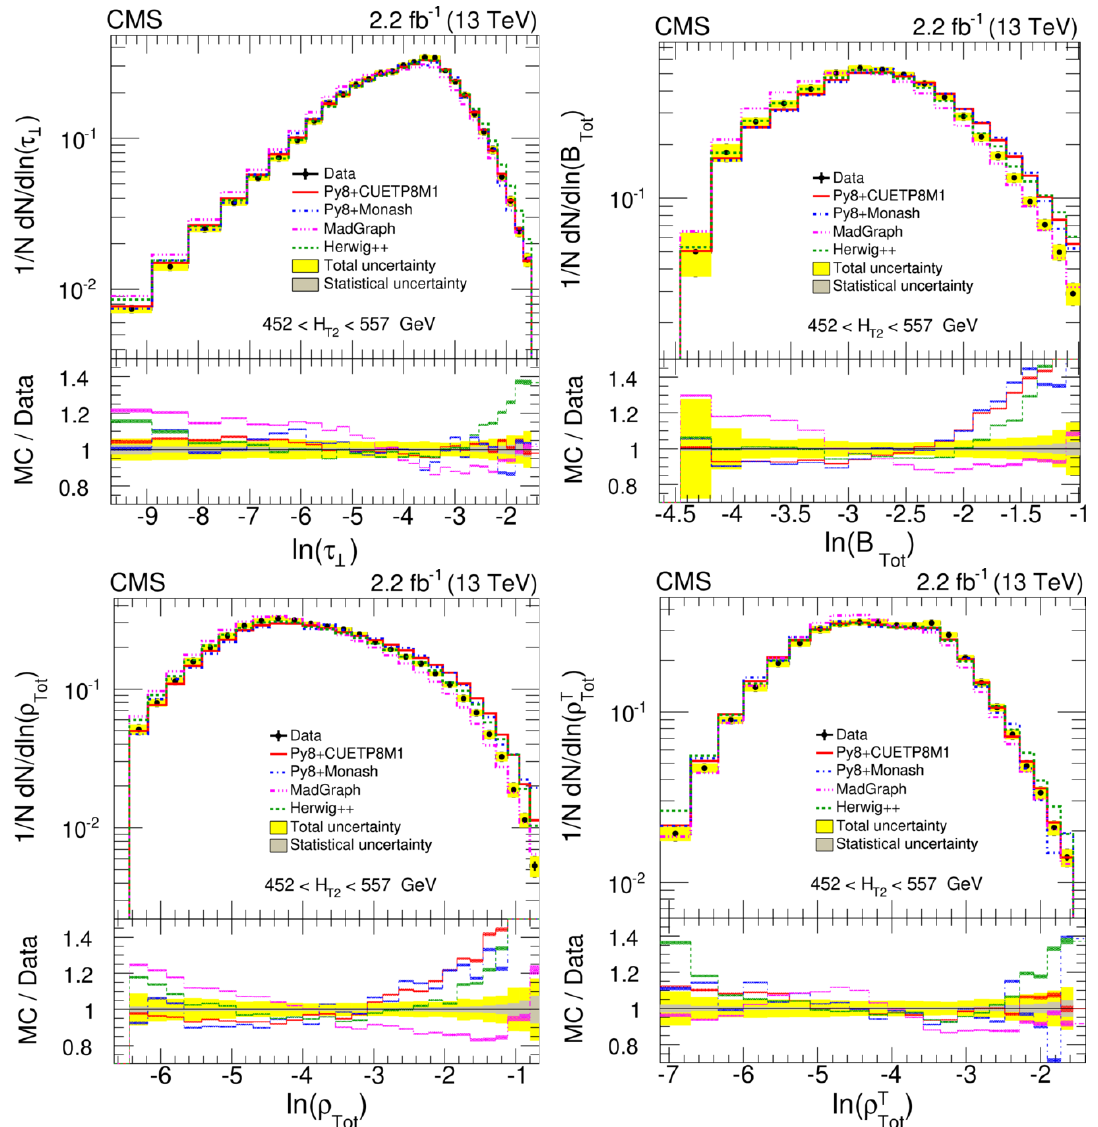
Figure 9 . Normalized di(cid:11)erential distributions of unfolded data compared with theoretical (MC) predictions of pythia 8 CUETP8M1 (red line), pythia 8 Monash (blue dash-dotted line), Mad- Graph 5 a mc@nlo (pink dash-dot-dotted line) and herwig++ (brown dash-dot-dotted line) as a function of ESV: complement of transverse thrust ( (cid:28) ? ) (upper left), total jet broadening ( B Tot ) (upper right), total jet mass ( (cid:26) Tot ) (lower left) and total transverse jet mass ( (cid:26) T 452 < H T ; 2 < 557 GeV. In each ratio plot, the inner gray band represents statistical uncertainty and the yellow band represents the total uncertainty (systematic and statistical components added in quadrature) on data and the MC predictions include only statistical uncertainty.